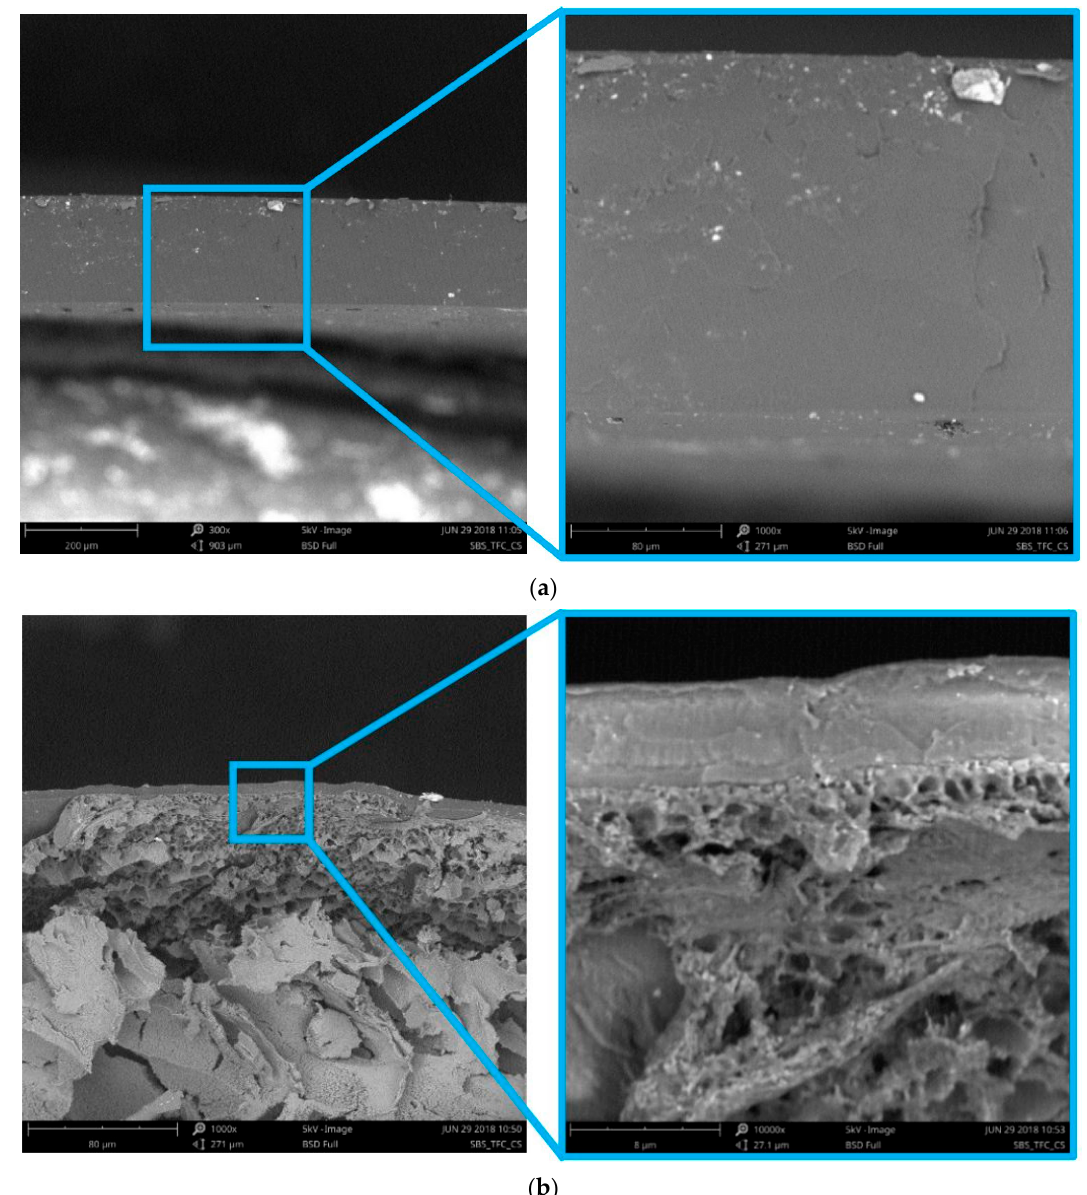
Figure 2. SEM image of the 159 µm thick dense SBS membrane ( a ); the 5 µm thin film composite SBS membrane ( b ).